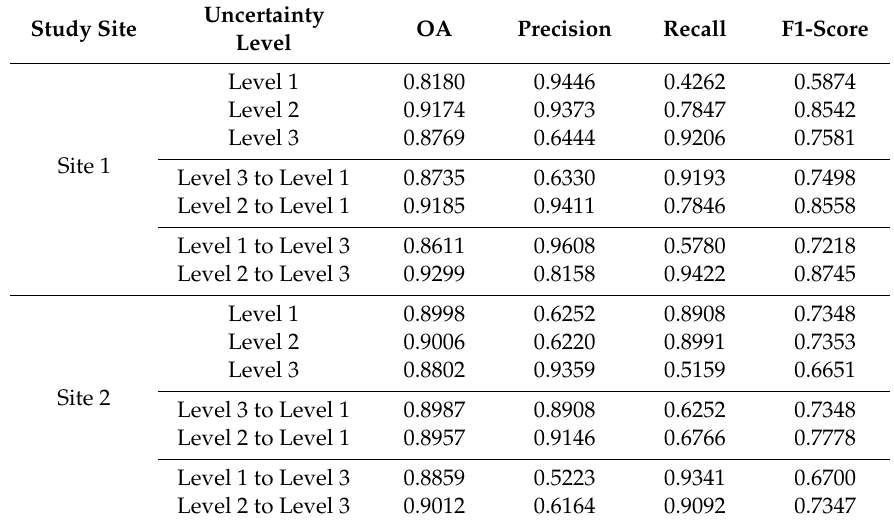
Table 5. Accuracy of the CD maps generated using the proposed method with different uncertainty